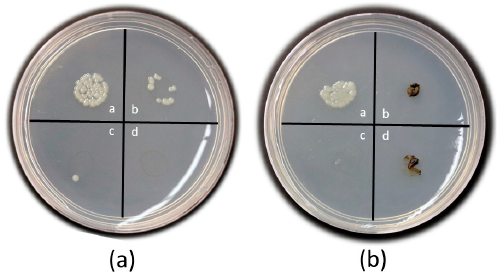
8 of 14 Figure 3. Antimicrobial activity of relevant MACAg components against E. coli . ( a ) Solid samples containing 0.25 mmol atoms of AgNPs in space b , MNPs in space c , and AC in space d were placed on an agar plate covered with 100 μ L of E. coli suspension of 2 × 10 8 CFU/mL (control is in space a ); ( b ) 100 μ L of liquid samples containing 2.5 × 10 − 5 mmol of Allura Red 40 ions in space a , Ag + ions in space b , Ag atoms in AgNPs (10 nm) in space c , and BH 4 − ions in space d were placed in the holes bored in an agar plate covered with 100 μ L of E. coli suspension of 0.5 × 10 8 CFU/mL. Only AgNPs and Ag + ions produced zone of inhibition. Figure 3a was published in reference [29]. AgNPs =